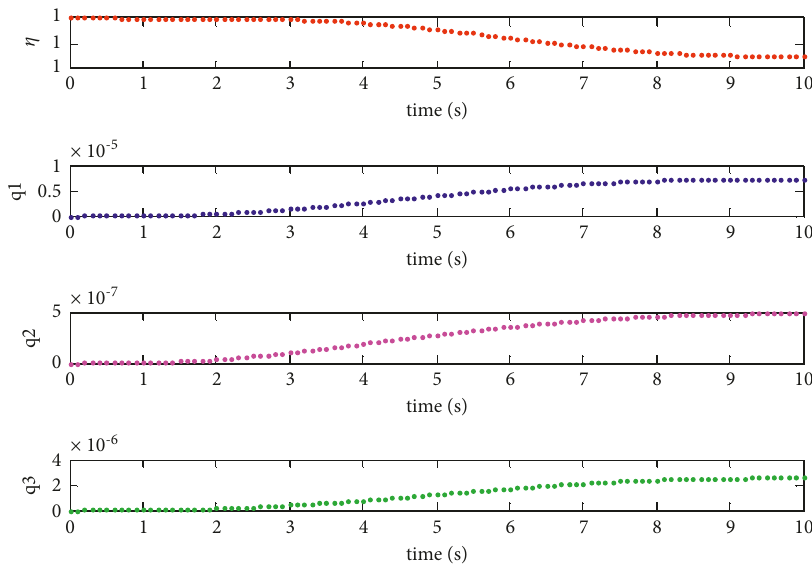
Figure 10: The attitude of the base obtained by the PSO algorithm.